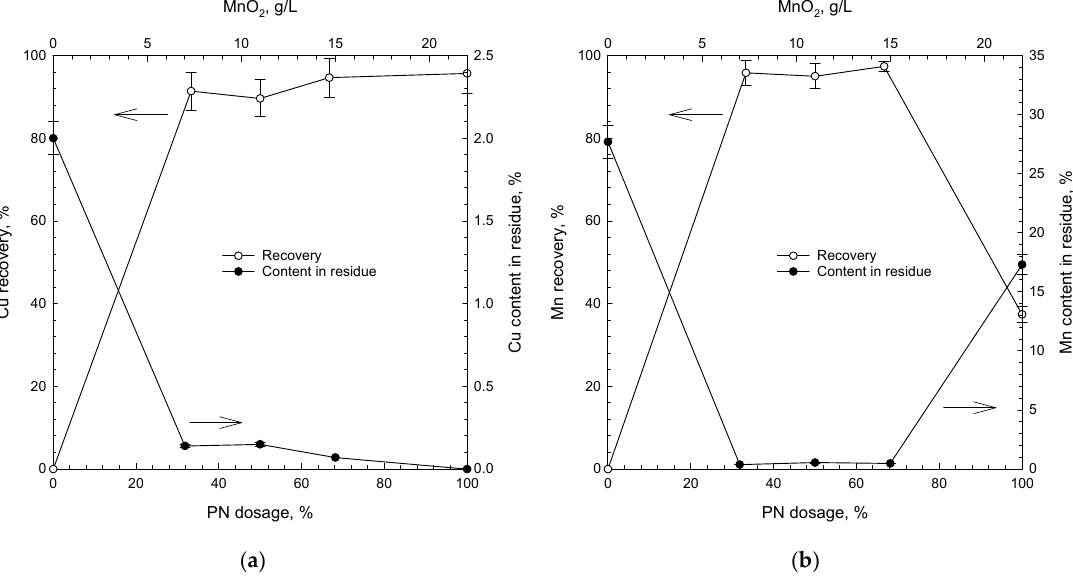
Figure 4. Leaching recovery and content in residue of ( a ) copper and ( b ) manganese in the presence of various amounts of polymetallic nodules (PN, in %) and corresponding MnO 2 (g / L) (1 M H 2 SO 4 , 1 M NaCl, 80 °C, 48 h).